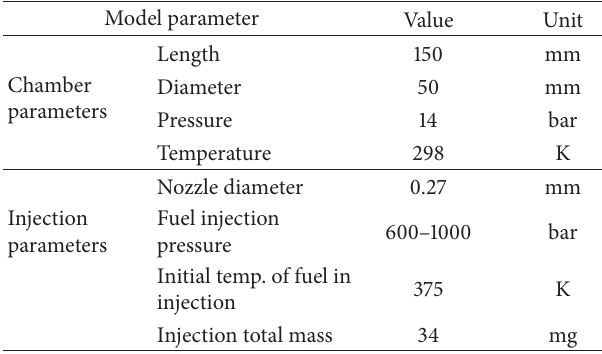
Table 4: Model setup for combustion chamber parameter and injec- tion